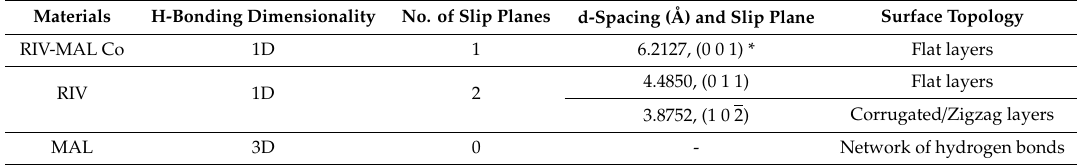
Table 4. Comparative assessment of molecular and supramolecular attributes of the coformer, API and cocrystal.